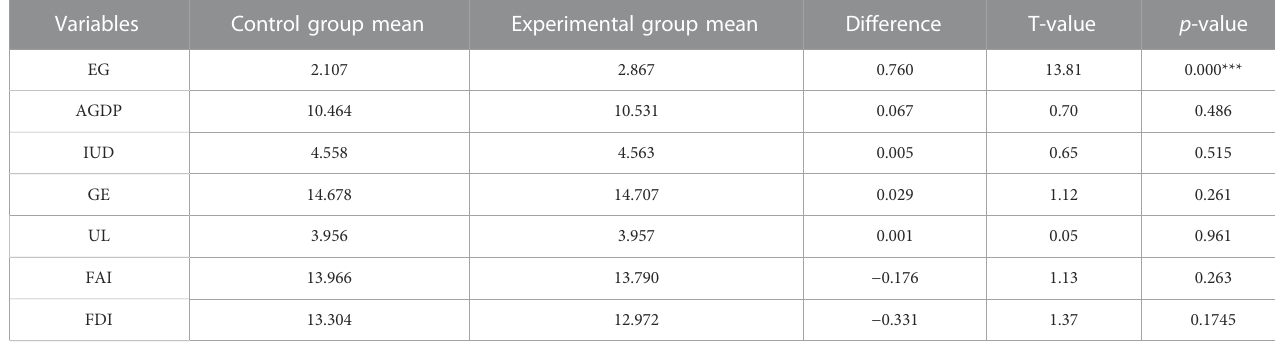
TABLE 4 Applicability test of the PSM-DID method (common support hypothesis).